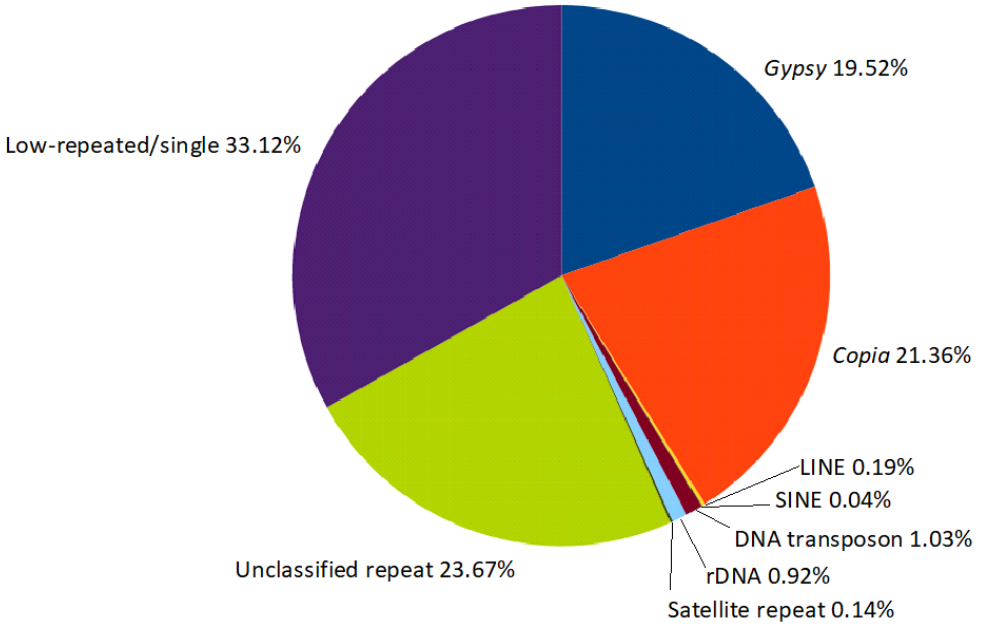
Figure 2. The composition of the metarepeatome of the five Asteraceae species evaluated.